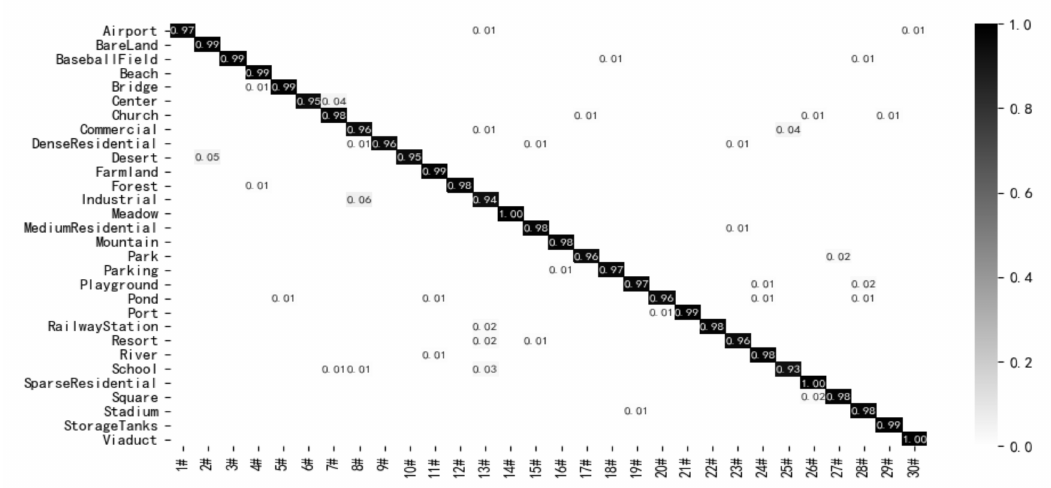
Figure 8. Confusion matrix of the LCNN-CMGF method on the AID (50/50)